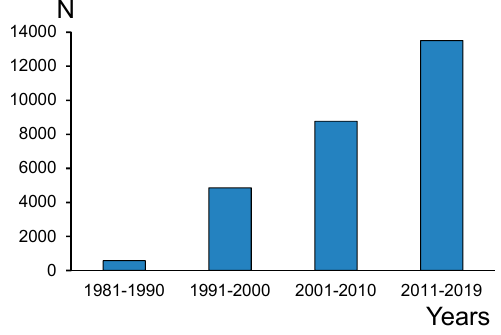
Figure 1. Number of publications containing ( N ) the terms ‘eicosapentaenoic’ or ‘docosahexaenoic’ in the Web of Science Core Collection during the last four decades.